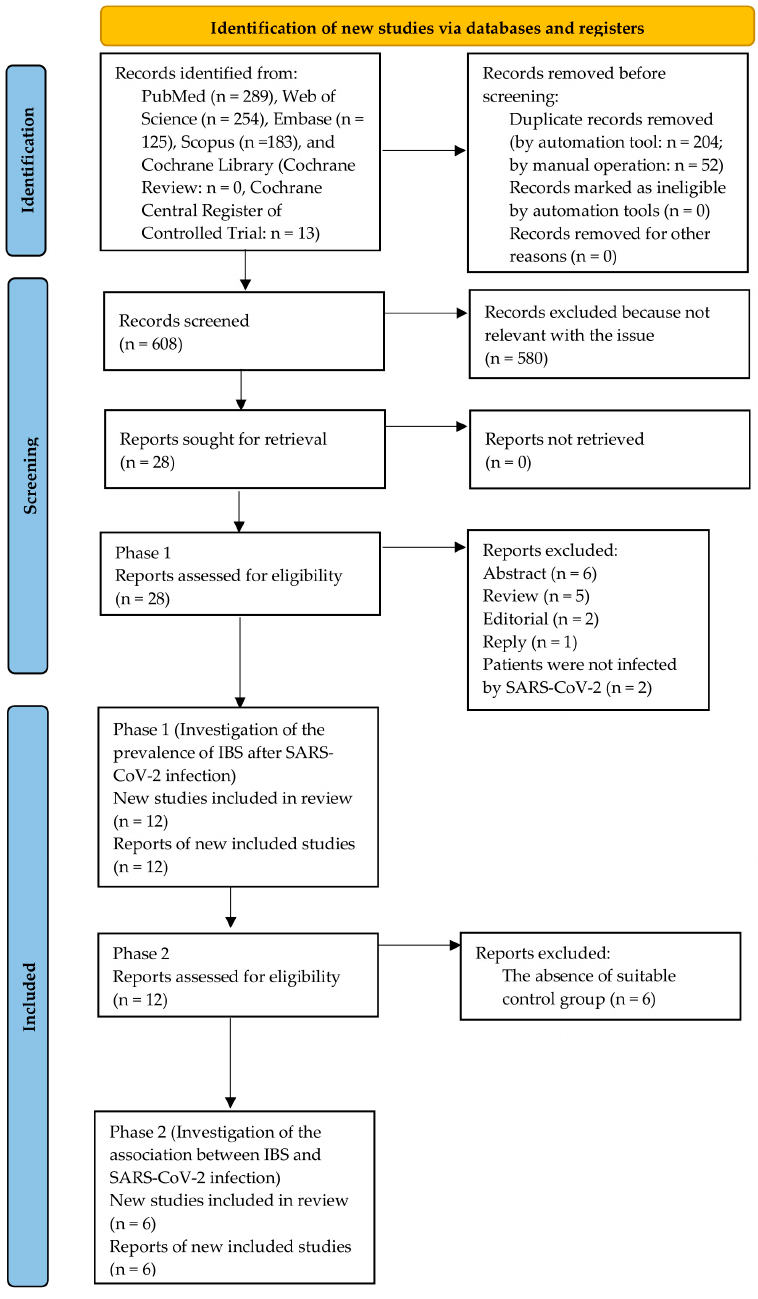
Figure 1. PRISMA study selection flow